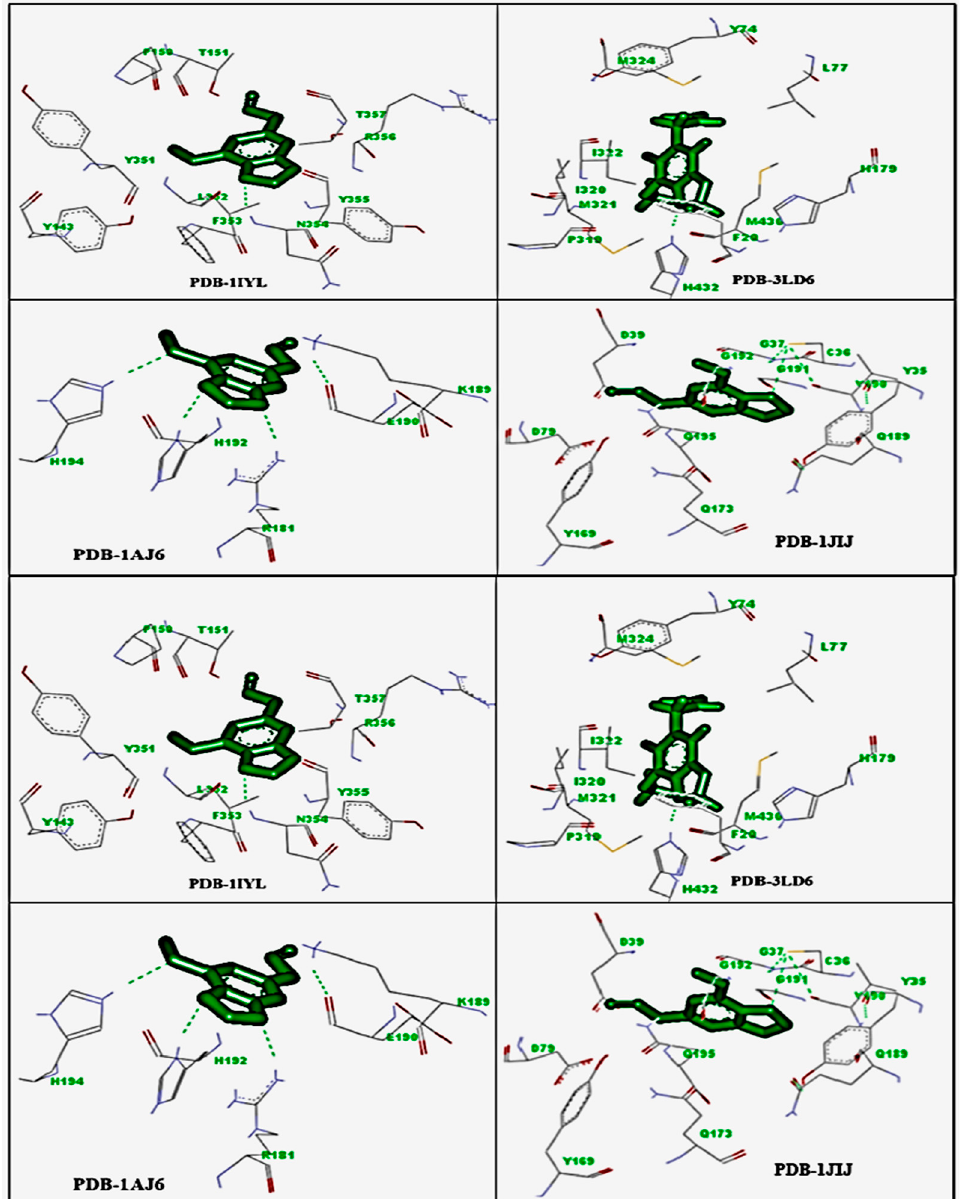
Figure 4. Interaction of 1IYL, 3LD6, 1AJ6, 1JIJ, 3N8Y, 3LN1, 3NM8, and 1HD2 protein with Ligand myristicin.